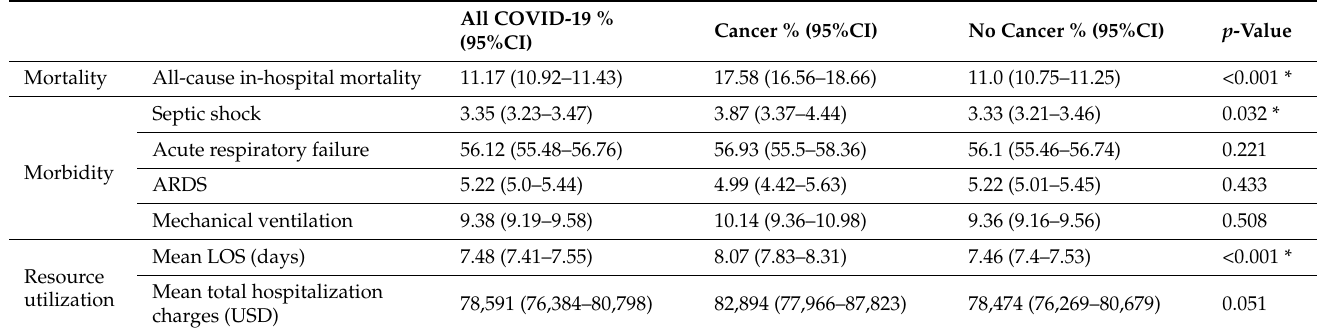
Table 2. Outcomes of patients admitted for COVID-19.